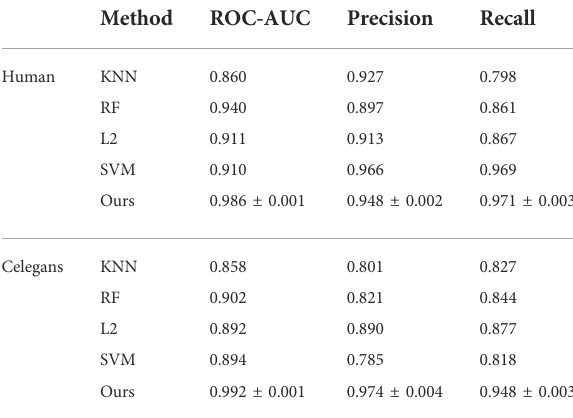
TABLE 2 The scores on Human dataset compared to traditional machine learning methods.